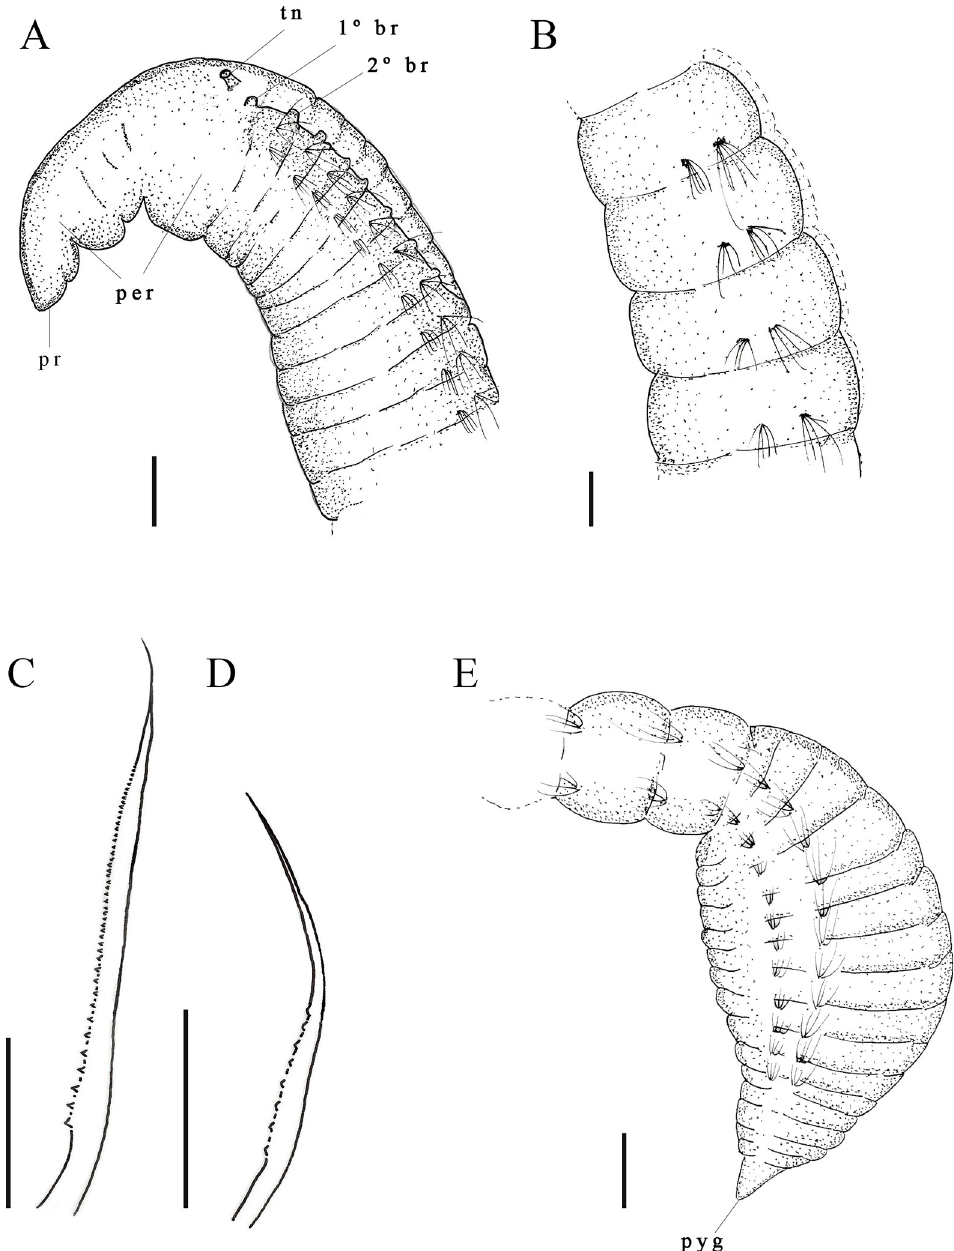
Fig 12. Kirkegaardia zafirae sp. nov. (A) anterior end, lateral view; (B) abdominal segments, lateral view; (C) neuropodial setae in posterior region; (D) notopodial setae in posterior region; (E) posterior parapodia, pre-pygidial region. A–E (MNRJP-003017). Scale bars: 100 μ m (A-E). Type locality. Atlantic Ocean: Campos Basin (Brazil). Habitat. Fine sediments, sand with biodebris, 26 to 43 m depth. Distribution. Presently known only from Atlantic Ocean: Campos Basin (Brazil). Methyl Green. No pattern, stain not retained. - Thoracic dorsal groove present; Notopodial modified setae from setigers 17; Pre-pygidial region expanded, ventral groove absent; Presence of a smaller segment demarcating the begin- ning of the pre-pygidial region. . . . . . .. . . .. . . .. . . .. . . .. . . .. . . .. . . .. Kirkegaardia jongo sp. nov. 5. Prostomium triangular; Thoracic crest narrow; Neuro and notosetae denticulate present from the setiger 50. . . . . . . .. . . .. . . .. . . .. . . .. . . . .. . . .. . . .. . . .. . . .. . .. . .. Kirkegaardia hampsoni